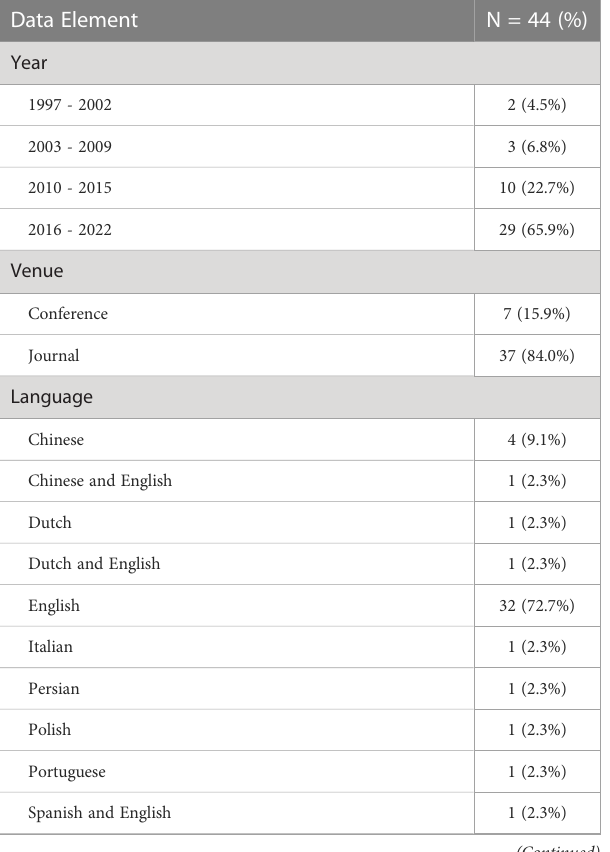
TABLE 2 Descriptive statistics related to publication timeline, venue, language of radiology reports, relevance to breast cancer and BCCC, and type of data used.